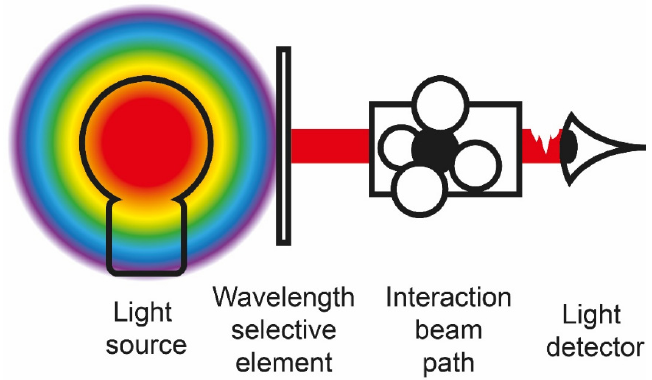
Figure 3. Conceptual illustration of an instrument for infrared spectroscopy. Commonly, such a setup comprises a light source, a wavelength selective element, a signal transducer, which defines the interaction path length, and a radiation detection device. This core setup is typically accompa- nied by sampling accessories such as sample feed conduits, flow cells, etc. as well as a robust hous- ing and system control, signal acquisition and data evaluation electronics and appropriate–in cur- rent times multivariate–data evaluation, mining, and classification software packages.